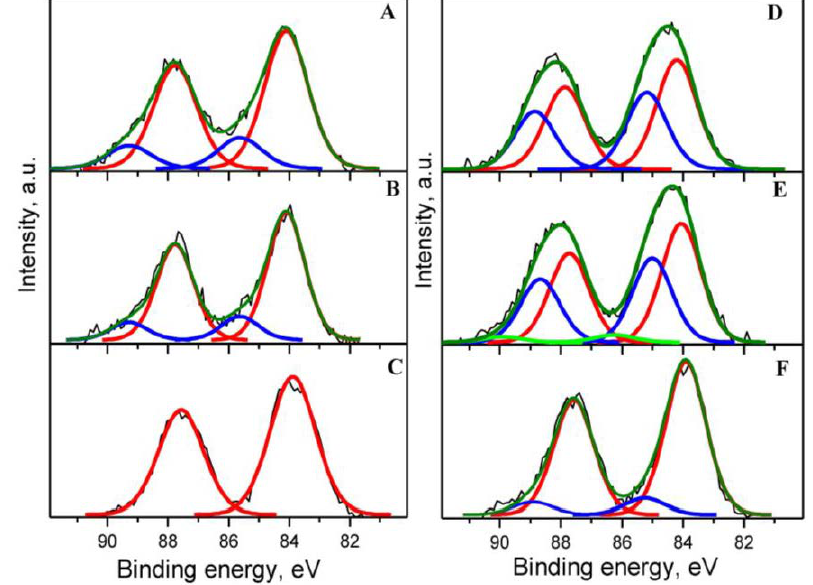
Figure 7. Comparison of experimental and fitted Au 4f XPS spectra of: ( A ) Au1YCeIM as received; ( B ) Au1YCeIM in situ oxidized at 350 °C; ( C ) Au1YCeIM used in CBO; ( D ) Au1YCeCP as received;